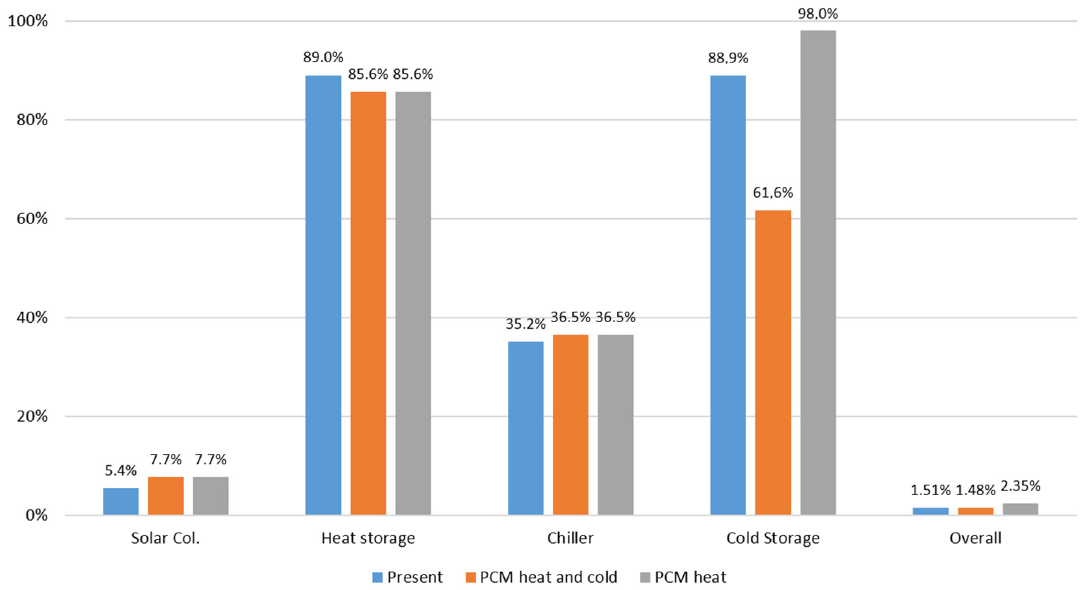
Figure 20. Final results of exergy analysis of the HVAC system with and without PCMs.